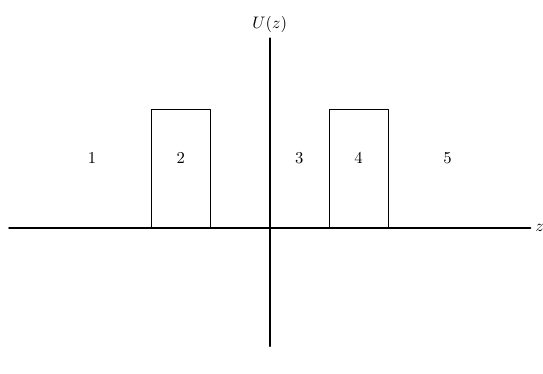
Figure 1 . The double potential barrier.